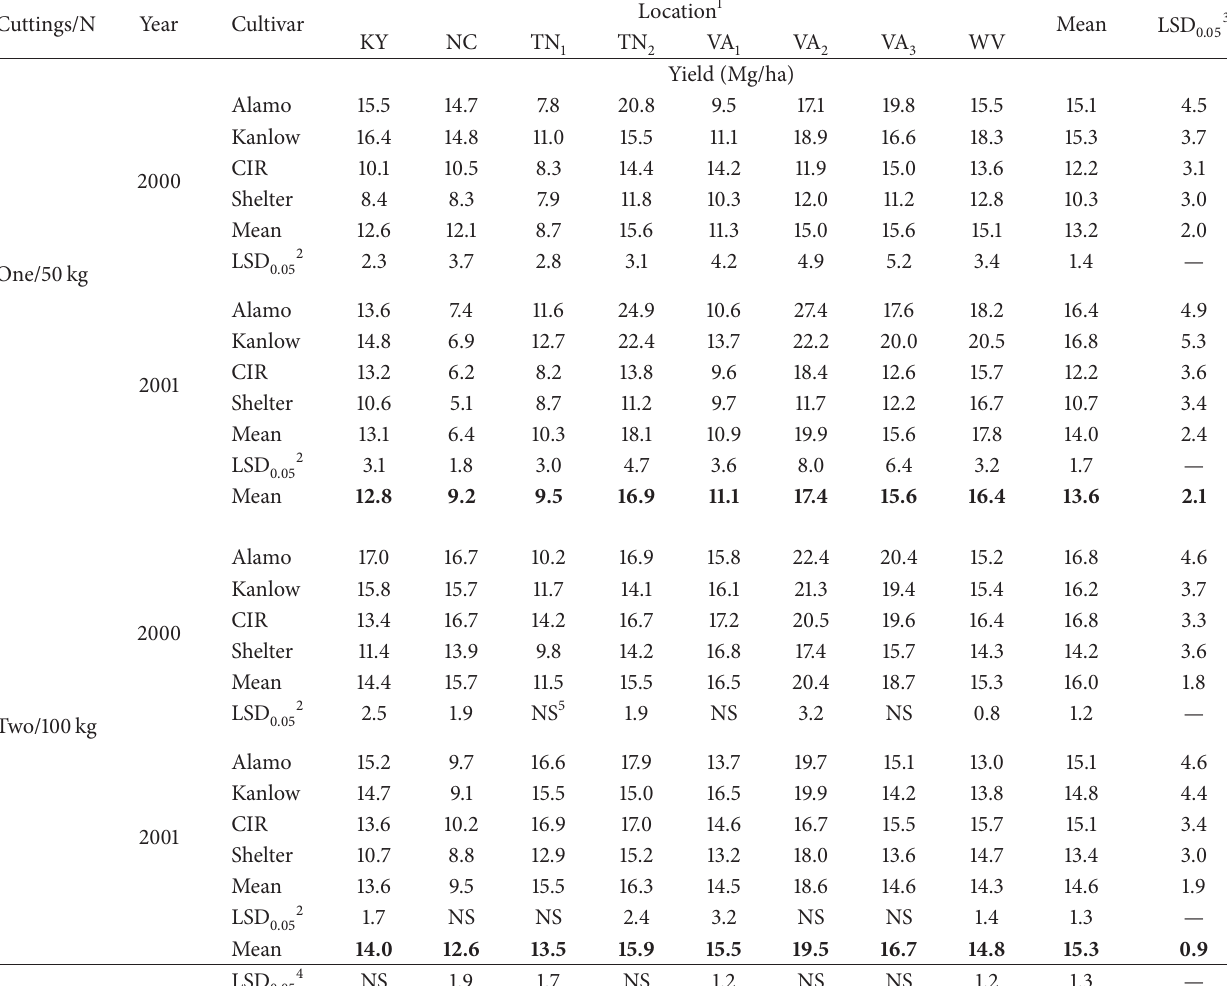
Table 5: Effect of management (one-cut (low input and management) and two-cut (high input and management)), year, and cultivar on yield of switchgrass grown at eight locations in upper southeast USA (CIR: Cave-in-Rock).